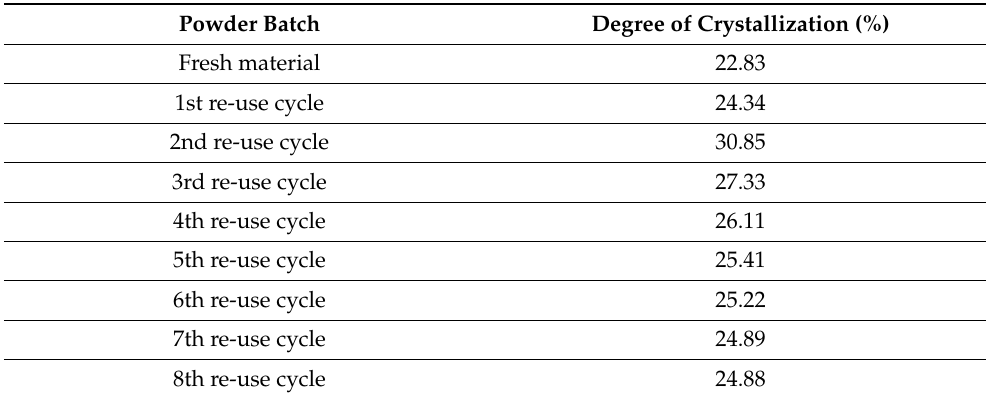
Table 7. Changes of a degree of crystallization of Laser PP CP 75 after eight re-use cycles.